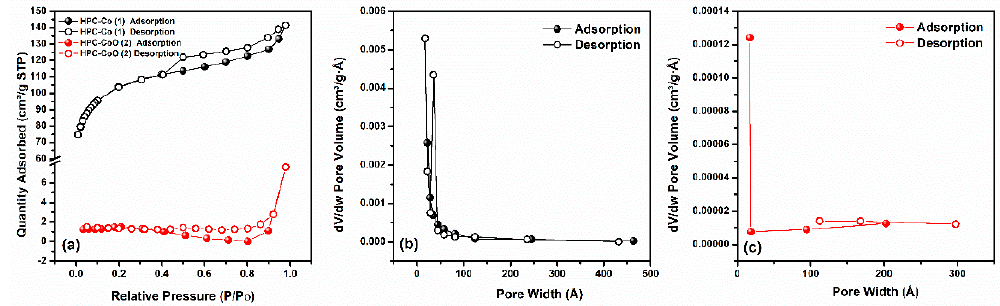
Figure 5. ( a ) BET sorption isotherm of nanocarbons HPC-Co (1) and HPC-CoO (2) at 77 K, ( b ) BJH pore size distribution curve of (1) and ( c ) BJH pore size distribution curve of (2).